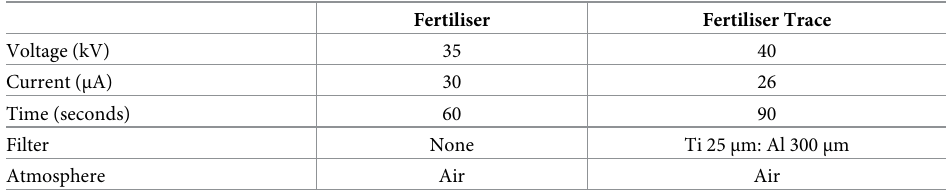
Table 5. Scanning parameters used for pXRF data